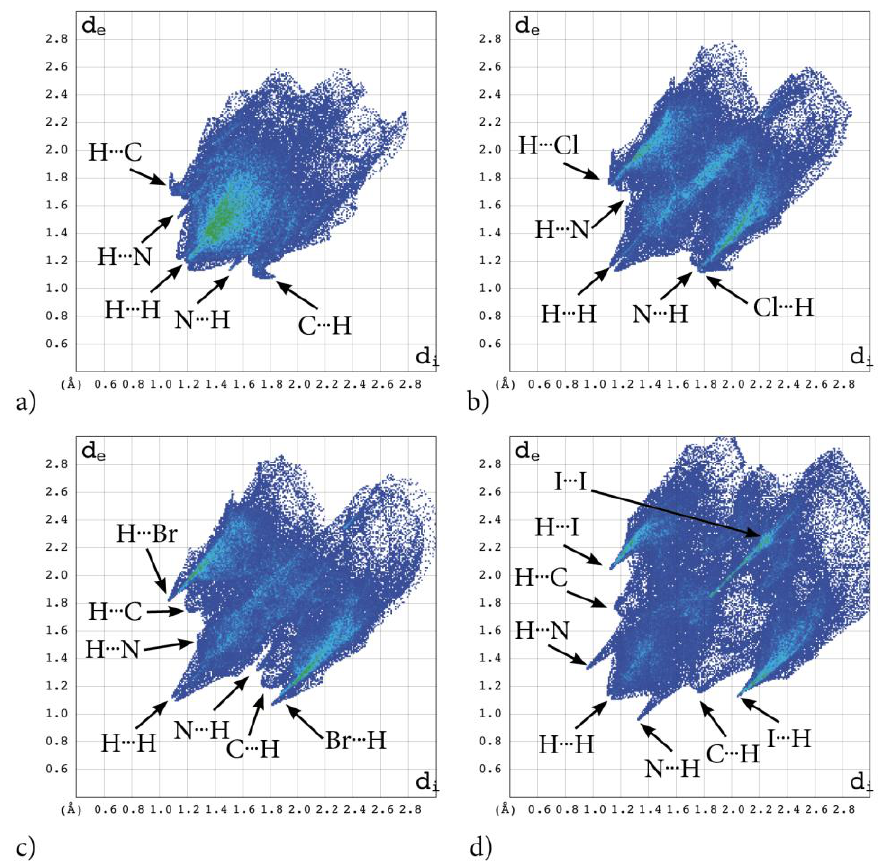
Figure 6. 2D molecular fingerprints of the interaction pattern in adamantylated 4,5,6,7-tetrahalogeno-1 H -benzimidazoles: ( a ) AB, ( b ) tClAB, ( c ) tBrAB and ( d ) tBrAB. Points on the plot corresponding to small contributions to the 3D HS surface are coloured dark blue, those with moderate contribution are coloured green and those with the greatest contribution are coloured red. All four fingerprint plots are coloured in the same scale.